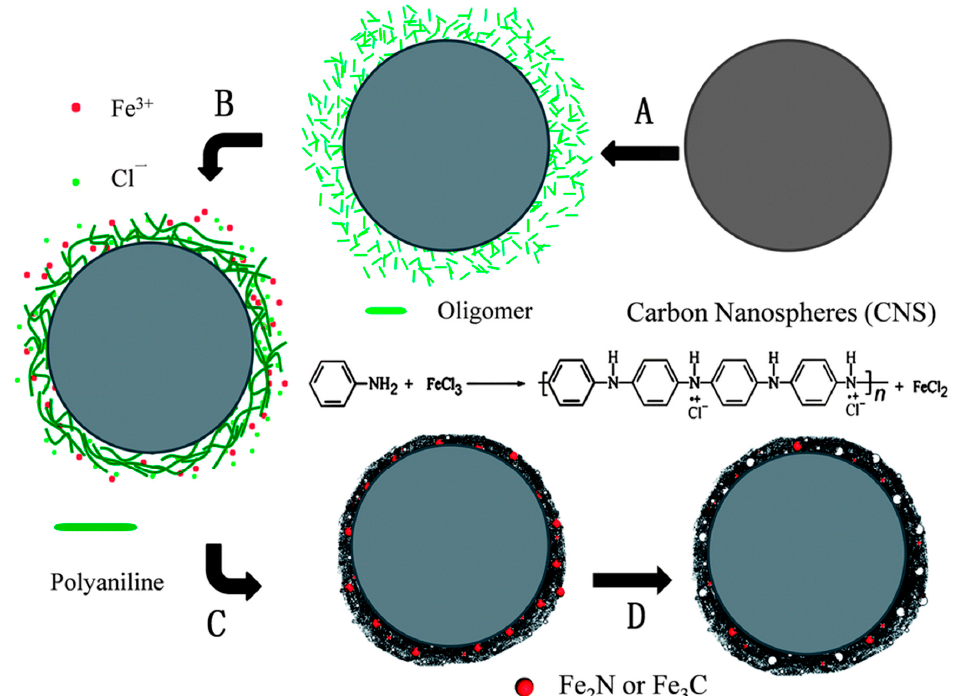
Figure 1. Schematic of the synthesis process of the FeN x C/C–F catalyst [51]. ( A ) Mixing of CNS with aniline oligomers. ( B ) Oxidative polymerization of aniline by addition of FeCl 3 solution. ( C ) First heat treatment in an ammonia atmosphere. ( D ) Acid leaching. The second heat treatment after acid leaching is not shown.